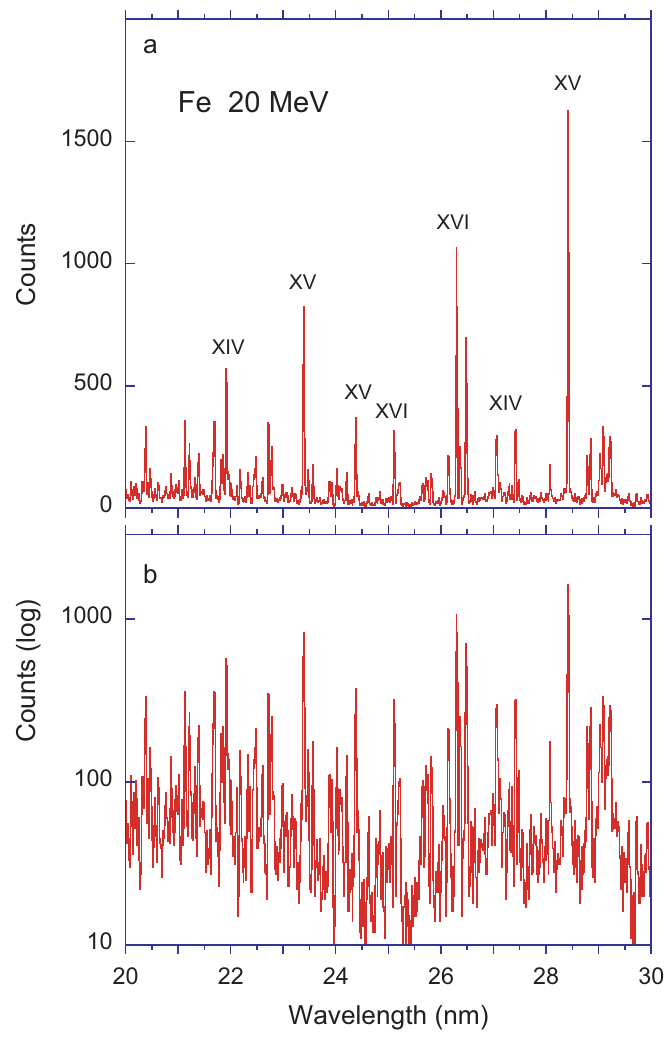
Figure 12. Beam–foil spectrum of Fe at an ion beam energy of 20 MeV in ( a ) linear and ( b ) logarithmic display. Slit width 40 µ m, line width (FWHM) 0.03 nm. The strongest lines are identified by the spectrum number. The charge state distribution ranges from q = 9 + to q = 16 + with a maximum for q = 12 + (Fe